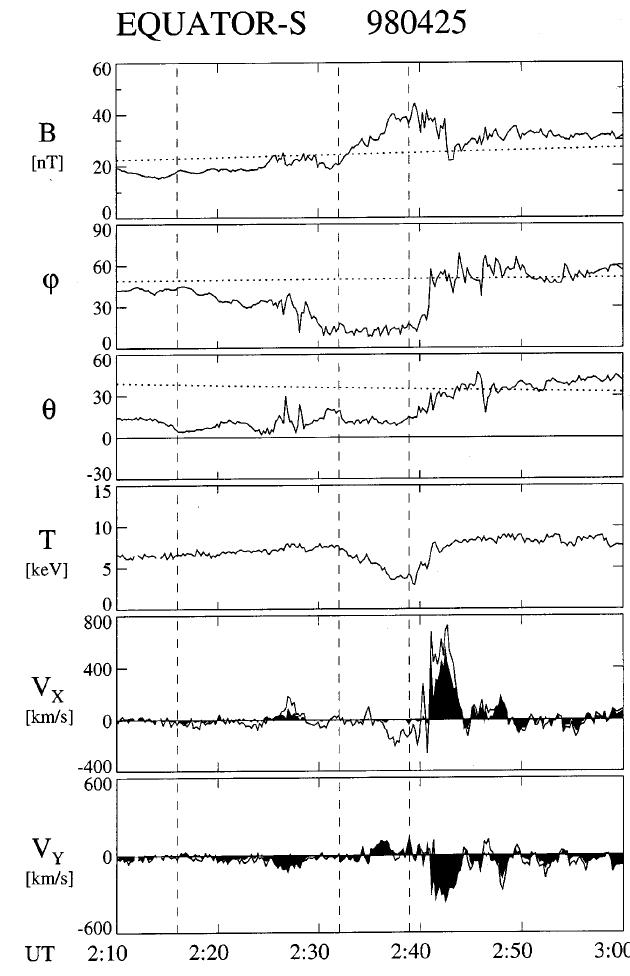
Fig. 6. Magnetic field and plasma data from Geotail between 0210 and 0300 UT. Shown are magnitude, azimuth ( / ) and polar angle ( h ) of the magnetic field, ion temperature, and X and Y components of the ion flow velocity in SM coordinates. Dotted lines accompanying the magnetic field data show values obtained from the Tsyganenko 89 model. The velocity components perpendicular to the magnetic field are shown as filled-in traces in the two bottom panels . The vertical lines show the onset times of the electrojet activations